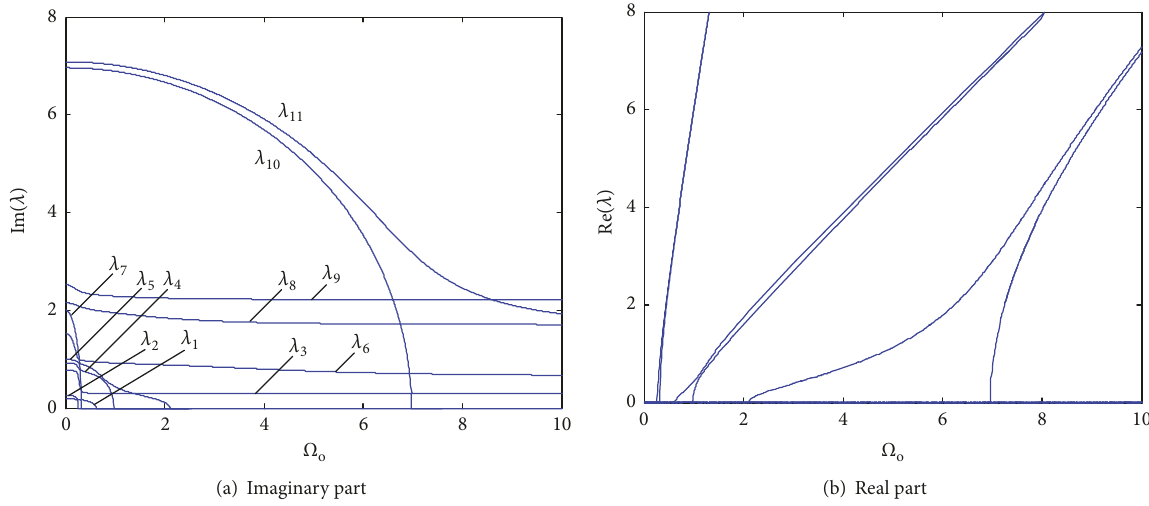
Figure 4: Imaginary and real parts of the eigenvalue for rotational